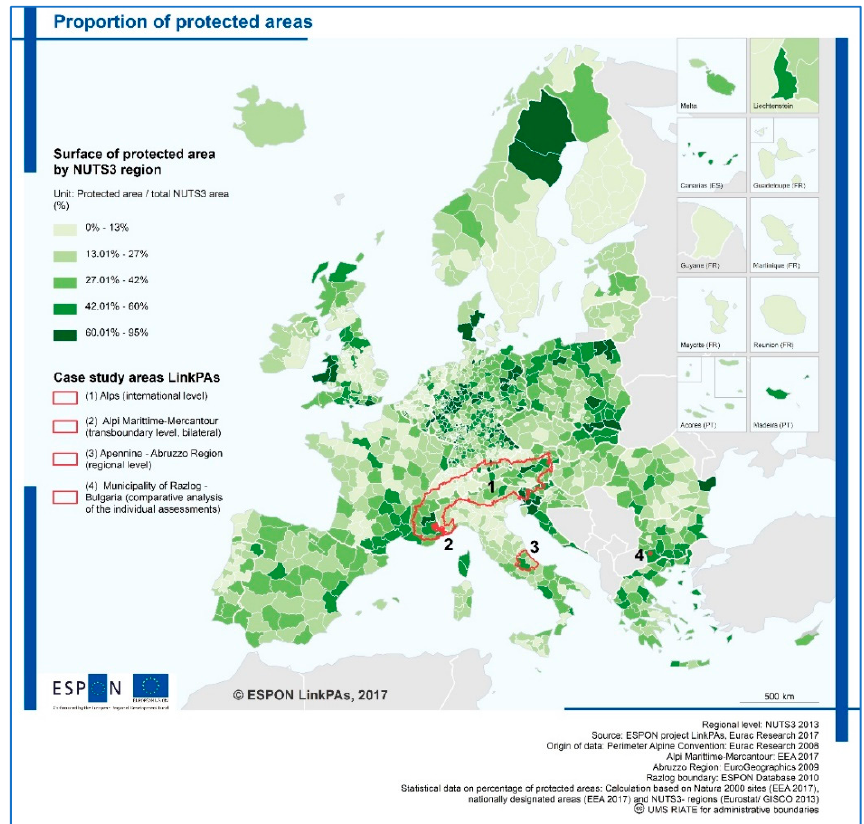
Figure 1. Proportion of protected areas. Source: ESPON LinkPAs, Final Main report, 2018, p. 2.